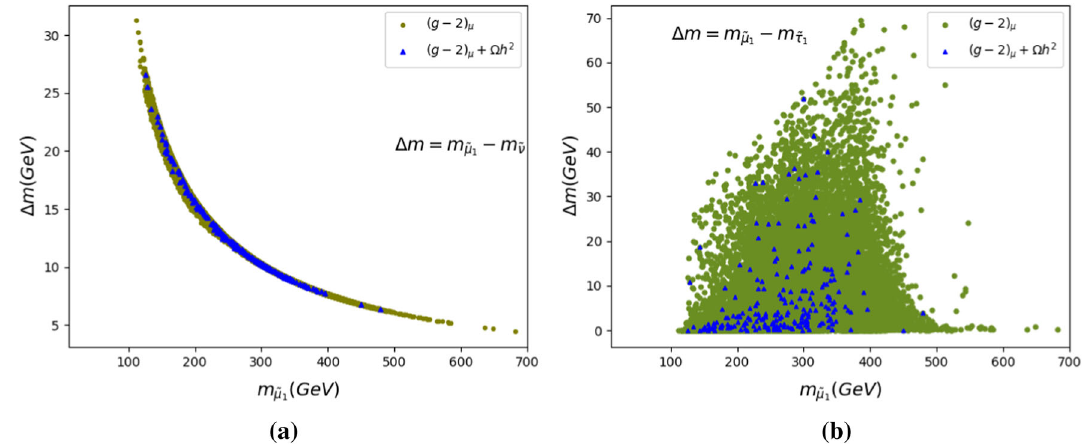
Fig. 2 The results of our parameter scan in the (cid:7) − m ˜ μ